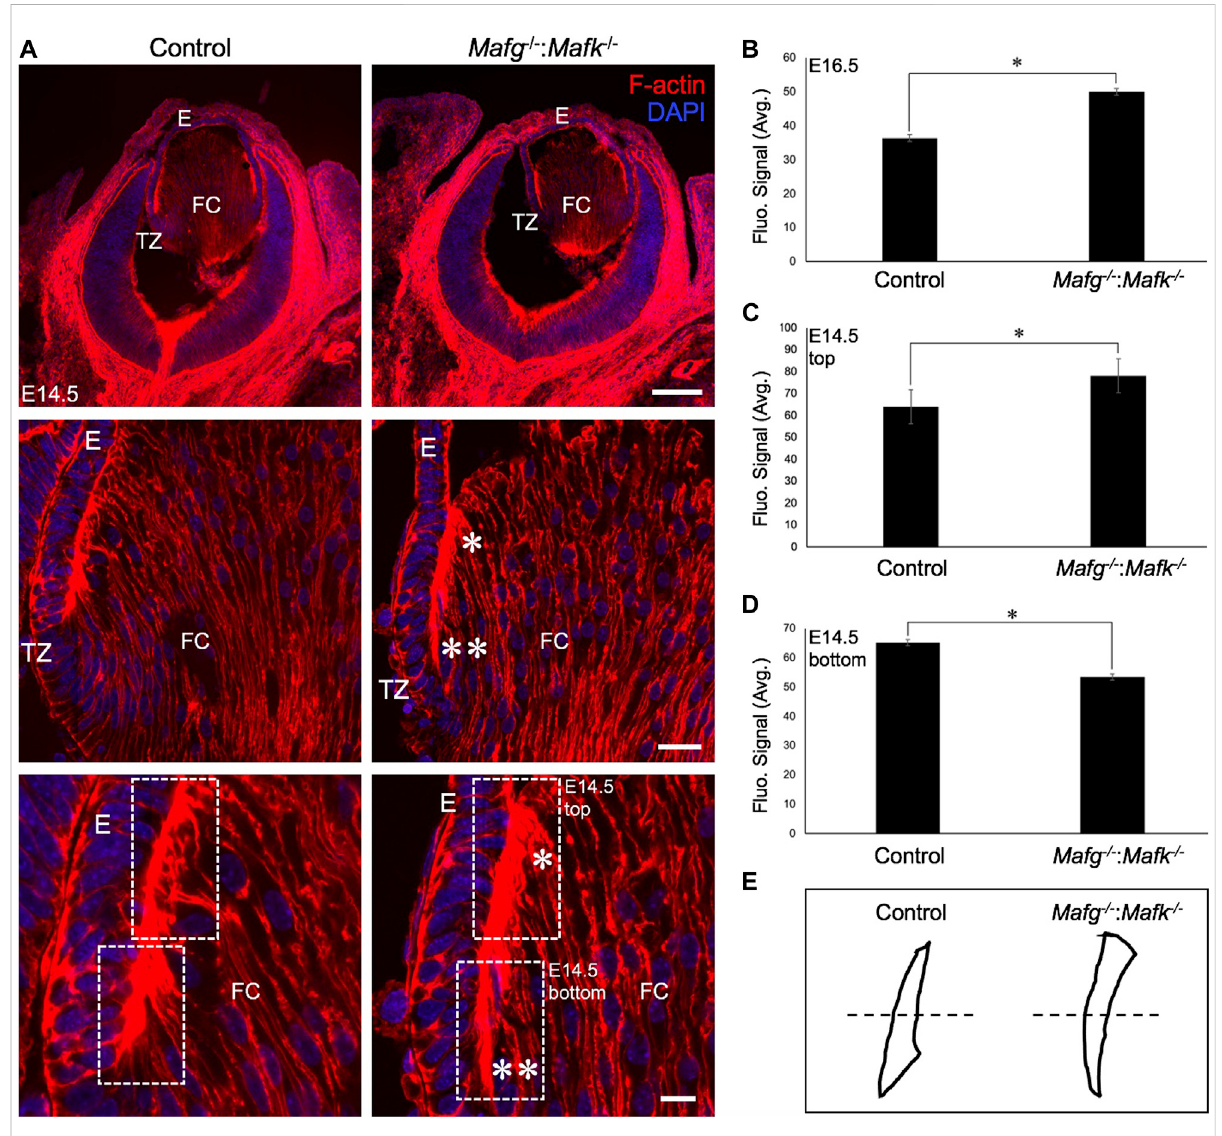
FIGURE 4 The F-actin distribution defects are detected in earlier stages of lens development in Mafg − / − : Mafk − / − mice. (A) Staining with phalloidin for visualizing F-actin and co-staining with DAPI to visualize nuclei demonstrate that Mafg − / − : Mafk − / − lenses at stage E14.5 exhibit abnormally reduced F-actin distribution (two asterisks) near the transition zone and the fulcrum region compared to the control. Further, Mafg − / − : Mafk − / − lenses exhibit abnormally elevated F-actin distribution (asterisk) in fi ber cells that have progressed further in differentiation. (B) Measurement of fl uorescence intensity signal near the transition zone region of E16.5 Mafg − / − : Mafk − / − lenses indicates elevated F-actin levels compared to control. (C) Measurement of fl uorescence intensity signal in fi ber cells progressed further in differentiation (represented by broken-line box termed “ top ” ) of E14.5 Mafg − / − : Mafk − / − lenses indicates elevated F-actin levels compared to control. (D) Measurement of fl uorescence intensity signal in fi ber cells nearthetransitionzoneand thefulcrumregion (representedbybroken-line box termed “ bottom ” )ofE14.5 Mafg − / − : Mafk − / − lenses indicatesreduced F-actin levels comparedto control. (E) Schematicofthe differential distributionofF-actin inthetop and bottom region (separatedby broken line)of control and Mafg − / − : Mafk − / − lenses at E14.5. Statistical signi fi cance was determined using a two-sample Student ’ s t -test. Abbreviation: E, Epithelium of the lens; FC, Fiber cells of the lens; TZ, Transition zone of the lens. Scale bar for Row 1, 20 μ m; Row 2, 10 μ m; Row 3, 8 μ